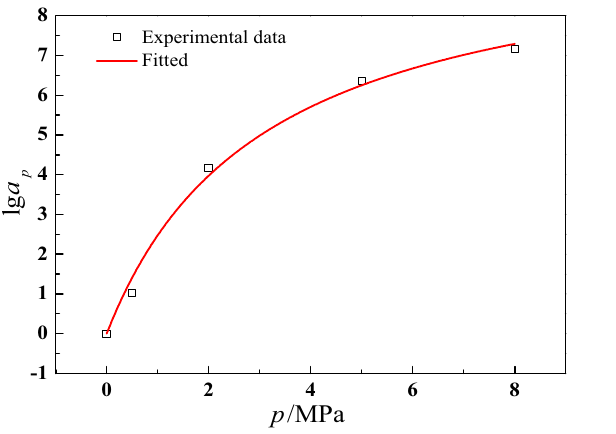
Figure 11. The pressure shift factor fitted result.